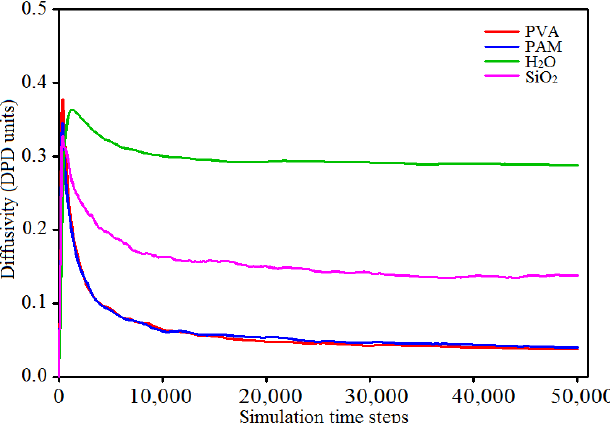
Figure 4. Relative concentration distribution functions of nano-silica in the 10% PVA/10% PAM/2% nano-silica blended hydrogel at different simulation time steps.